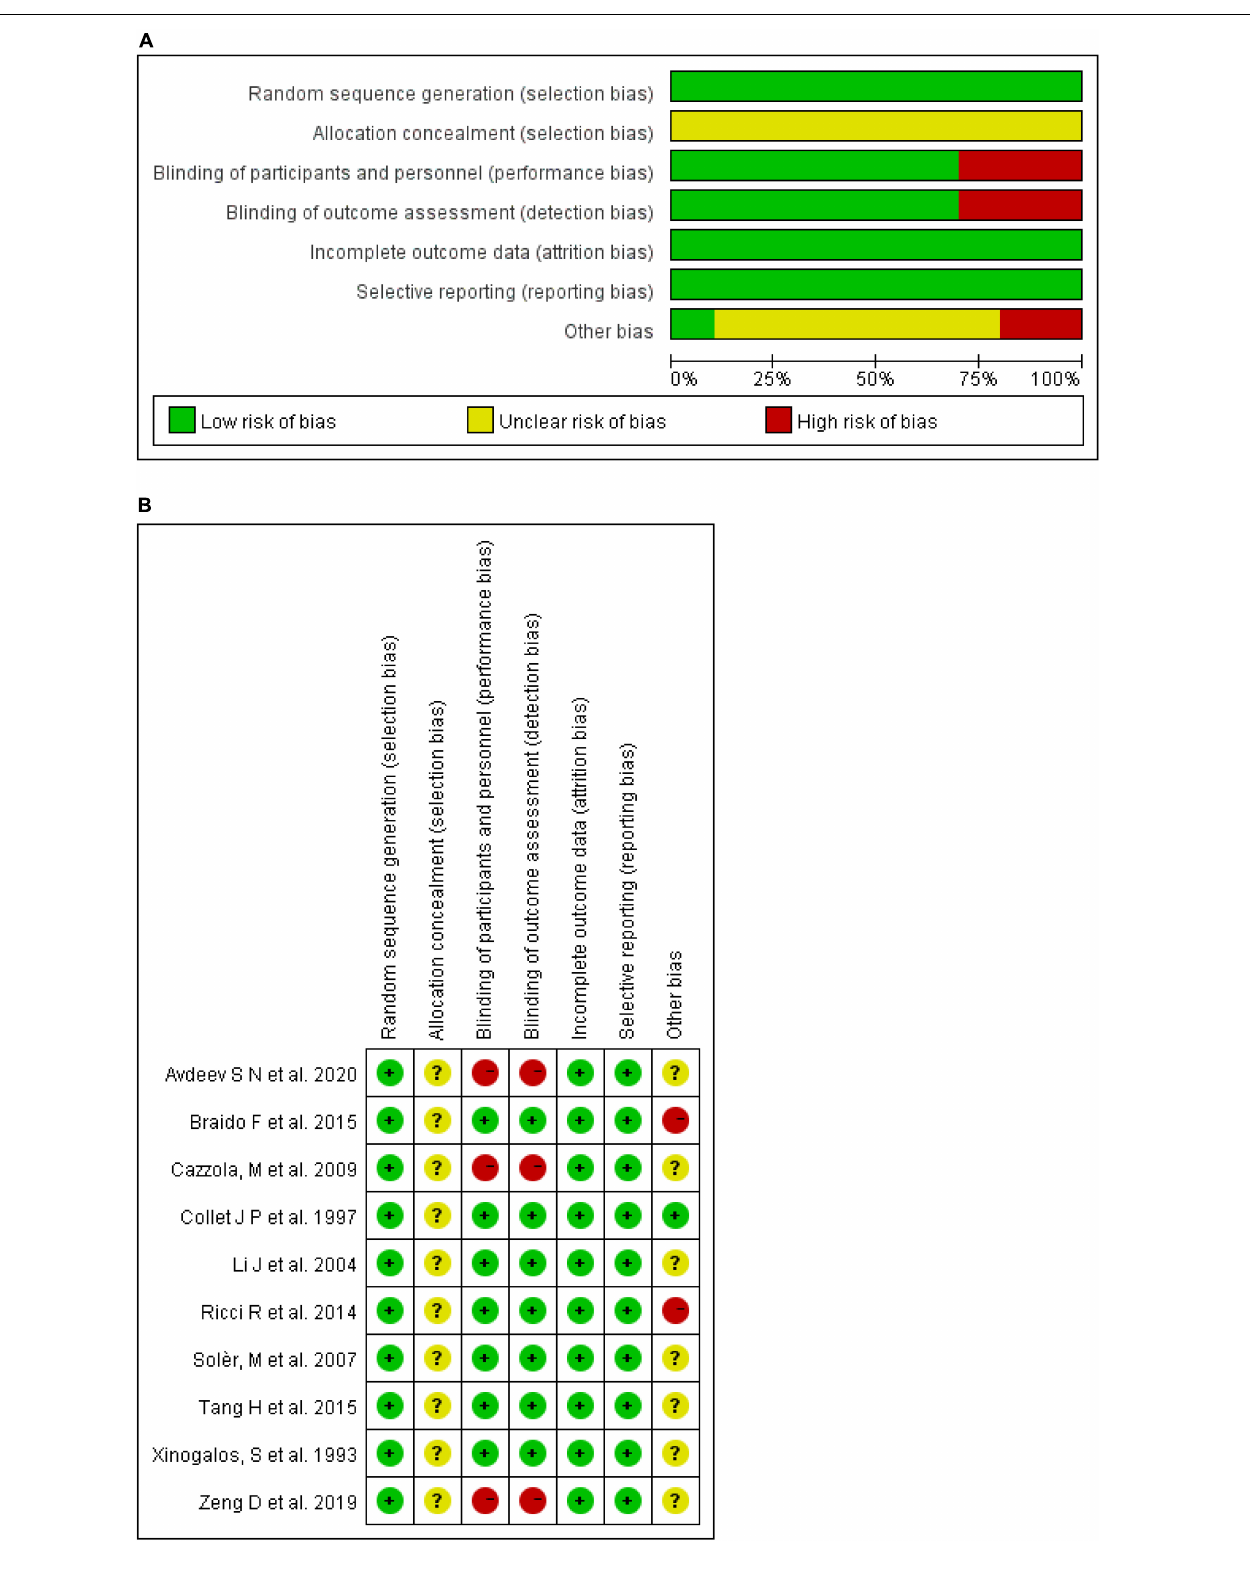
FIGURE 2 | Risk of bias. (A) Each risk of bias item presented as percentages across all included studies. (B) Each risk of bias item for each included study.